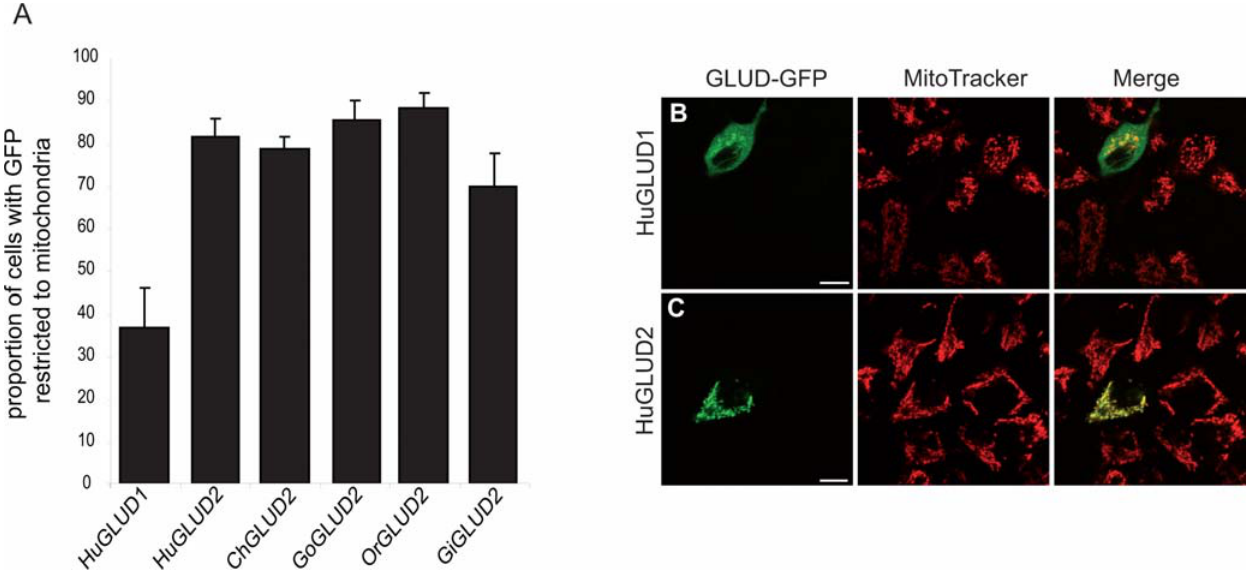
Figure 3. Subcellular Localization of GLUD2 from Hominoids and Human GLUD1. (A) Proportion of transfected HeLa cells in which GFP signals from the different recombinant GLUD-GFP fusion proteins were only detected in mitochondria. Human GLUD1 shows significantly lower mitochondrial localization specificities than GLUD2 from any of the apes ( P , 0.01, Tukey’s Post Hoc test). GLUD2 from gibbons shows a lower mean mitochondrial targeting capacity in the experiments than GLUD2 from the other apes (which might indicate that some of the enhanced targeting capacity was lost on the gibbon lineage), although this difference is only statistically significant when compared to GoGLUD2 and OrGLUD2 ( P , 0.05, Tukey’s Post Hoc test). We note that LN229 and COS7 cells could not be analyzed, as these cell lines do not tolerate expression of additional recombinant glutamate dehydrogenase (presumably due to the higher expression levels of recombinant GLUD proteins in these cells upon transfection). (B) and (C) HeLa cells transfected with human GLUD1 and GLUD2 GFP fusion constructs, respectively (mitochondria labeled with MitoTracker, red). Scale bars=10 m m. Unmerged images are shown in Figure S3.